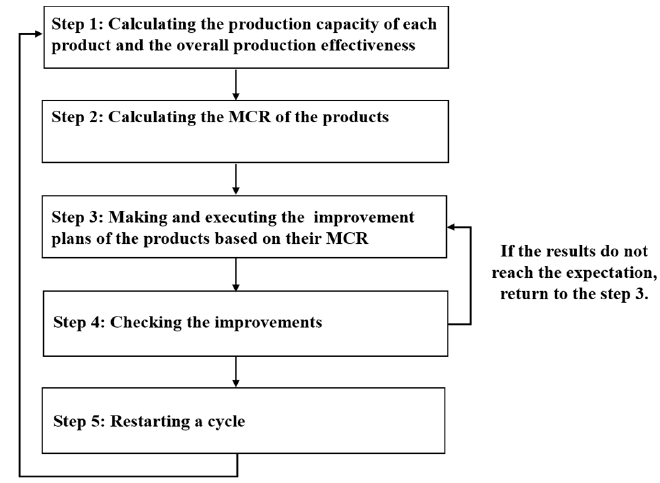
Figure 2. Flow chart of application framework.